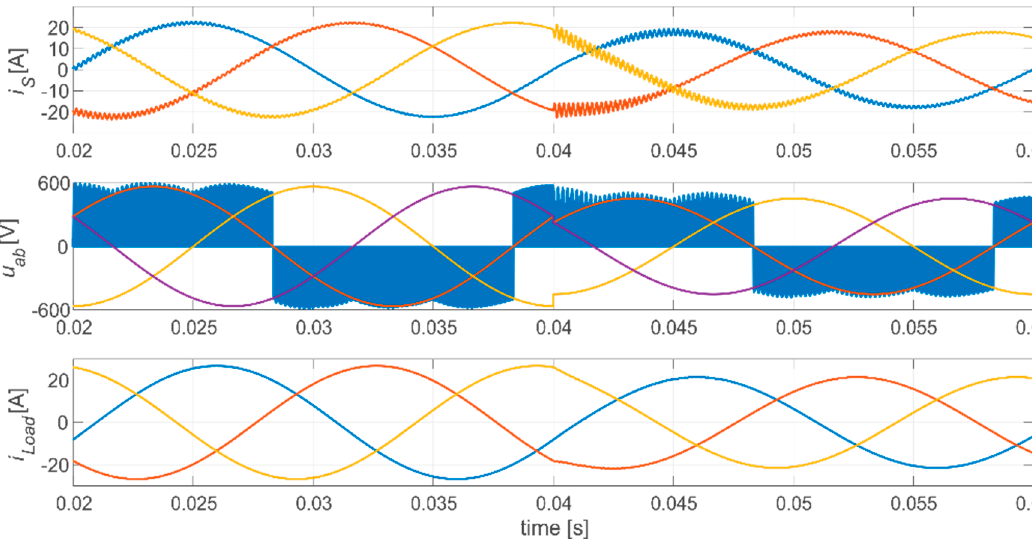
Figure 8. The results of software verification the system.